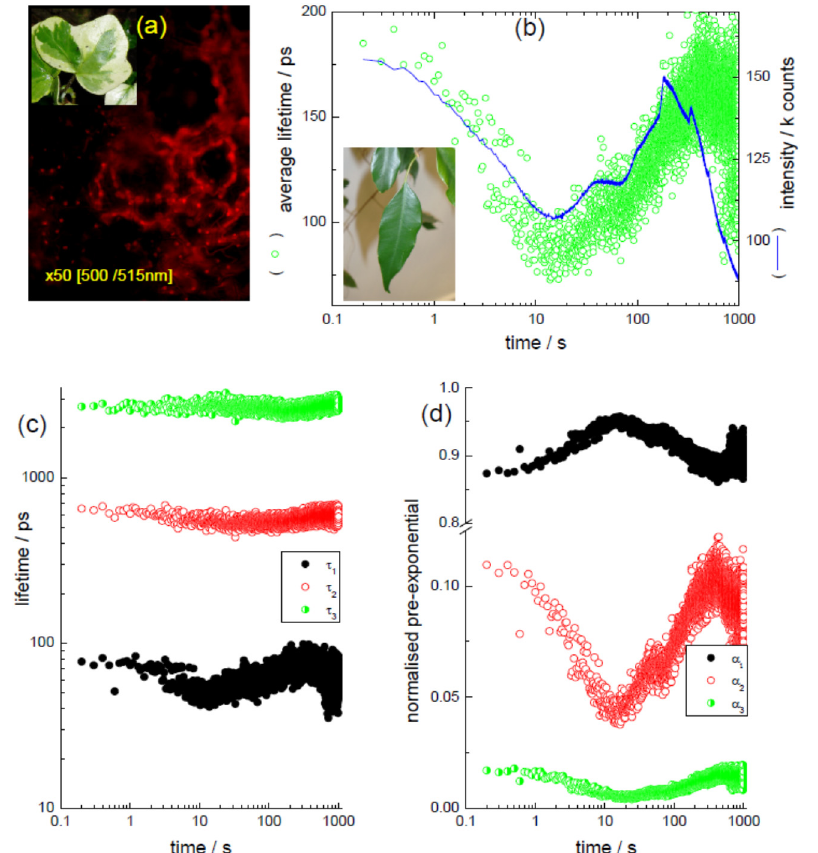
Figure 2. ( a ) Microscopy image, via filters of chloroplast emission from a leaf ( Hedera— inset); ( b ) outcome of a kinetic TCSPC measurement showing both the variation of fluorescence intensity and average lifetime for a whole leaf ( Ficus —inset). The excitation was at 478 nm and the emission was selected using a filter for large spectral coverage. Three exponential analysis of the kinetic TCSPC measurement, showing ( c ) the lifetime values and ( d ) their normalised pre-exponential contribution. Adapted from